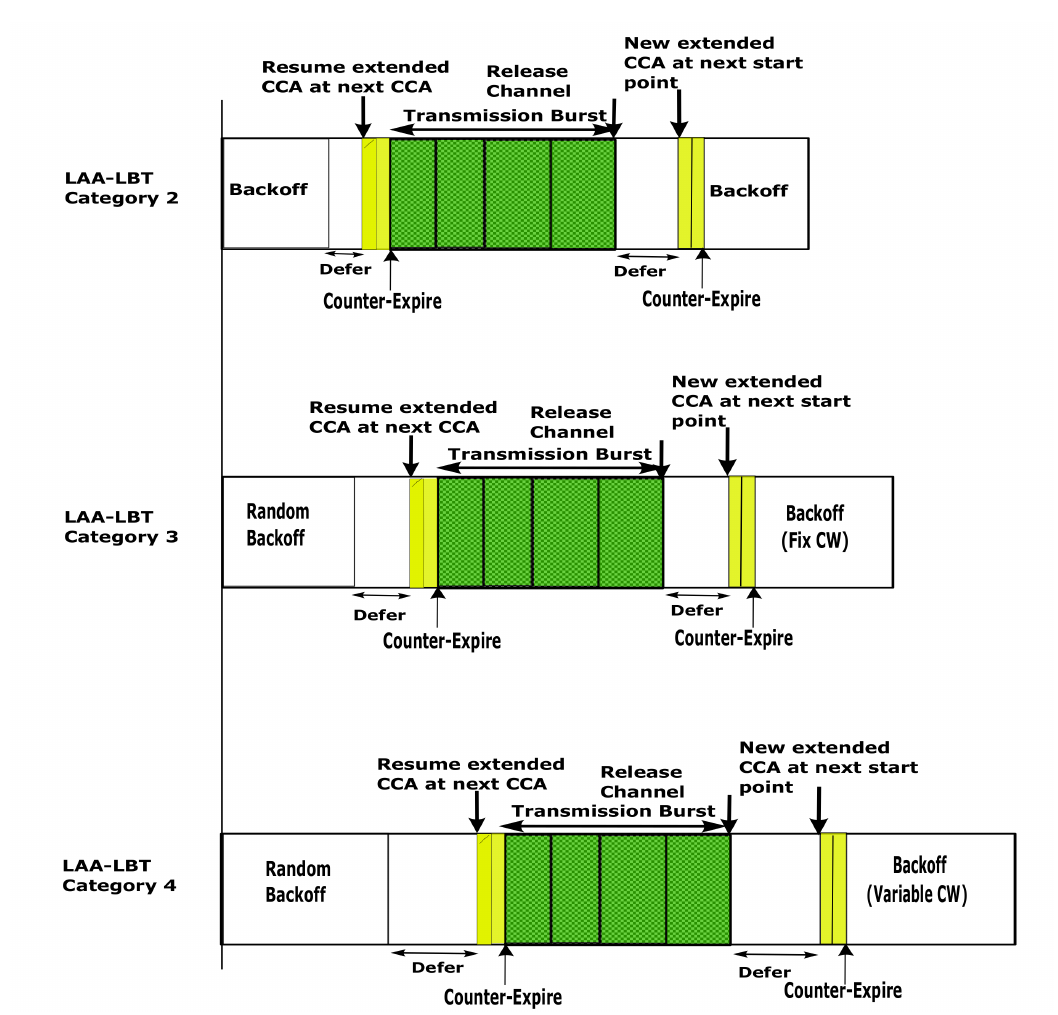
Figure 2. Various LAA-LBT categories for channel access mechanisms of LTE when operating in the unlicensed